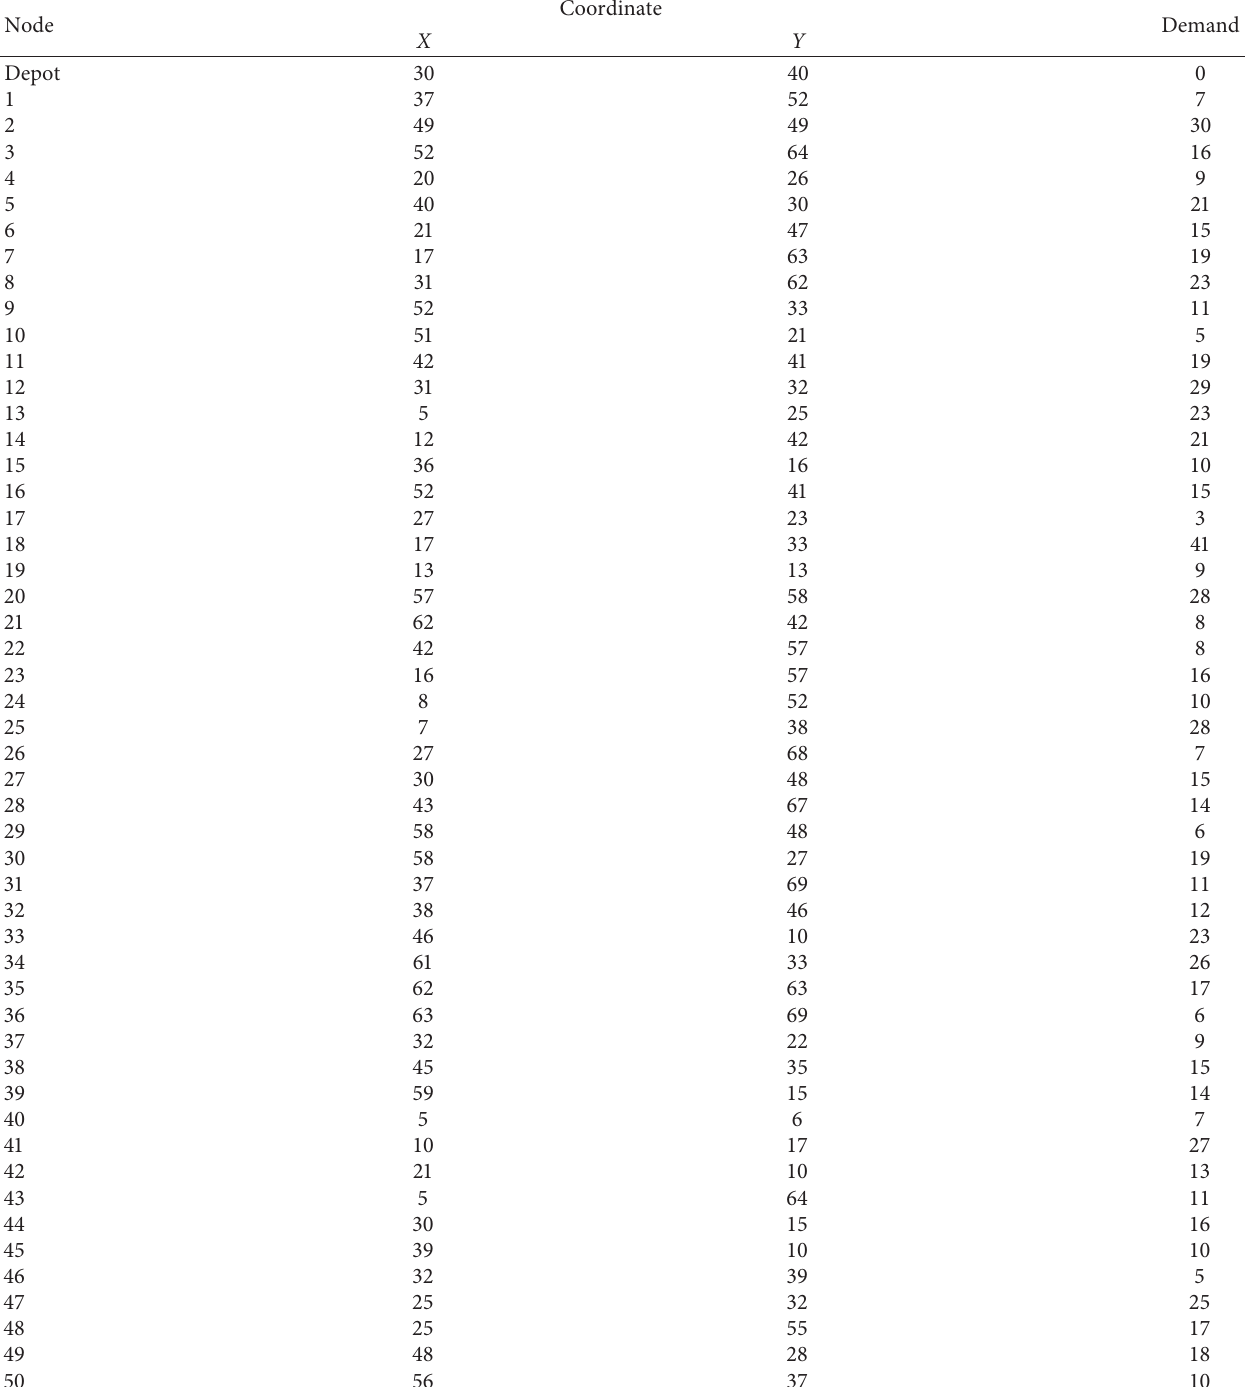
Table 3: Problem of 50